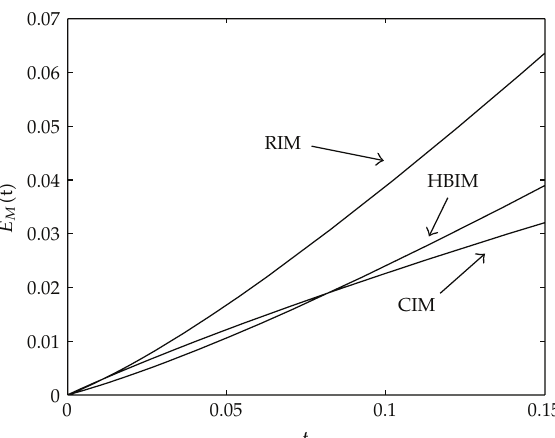
Figure 4: E M against t for the cooling condition at small